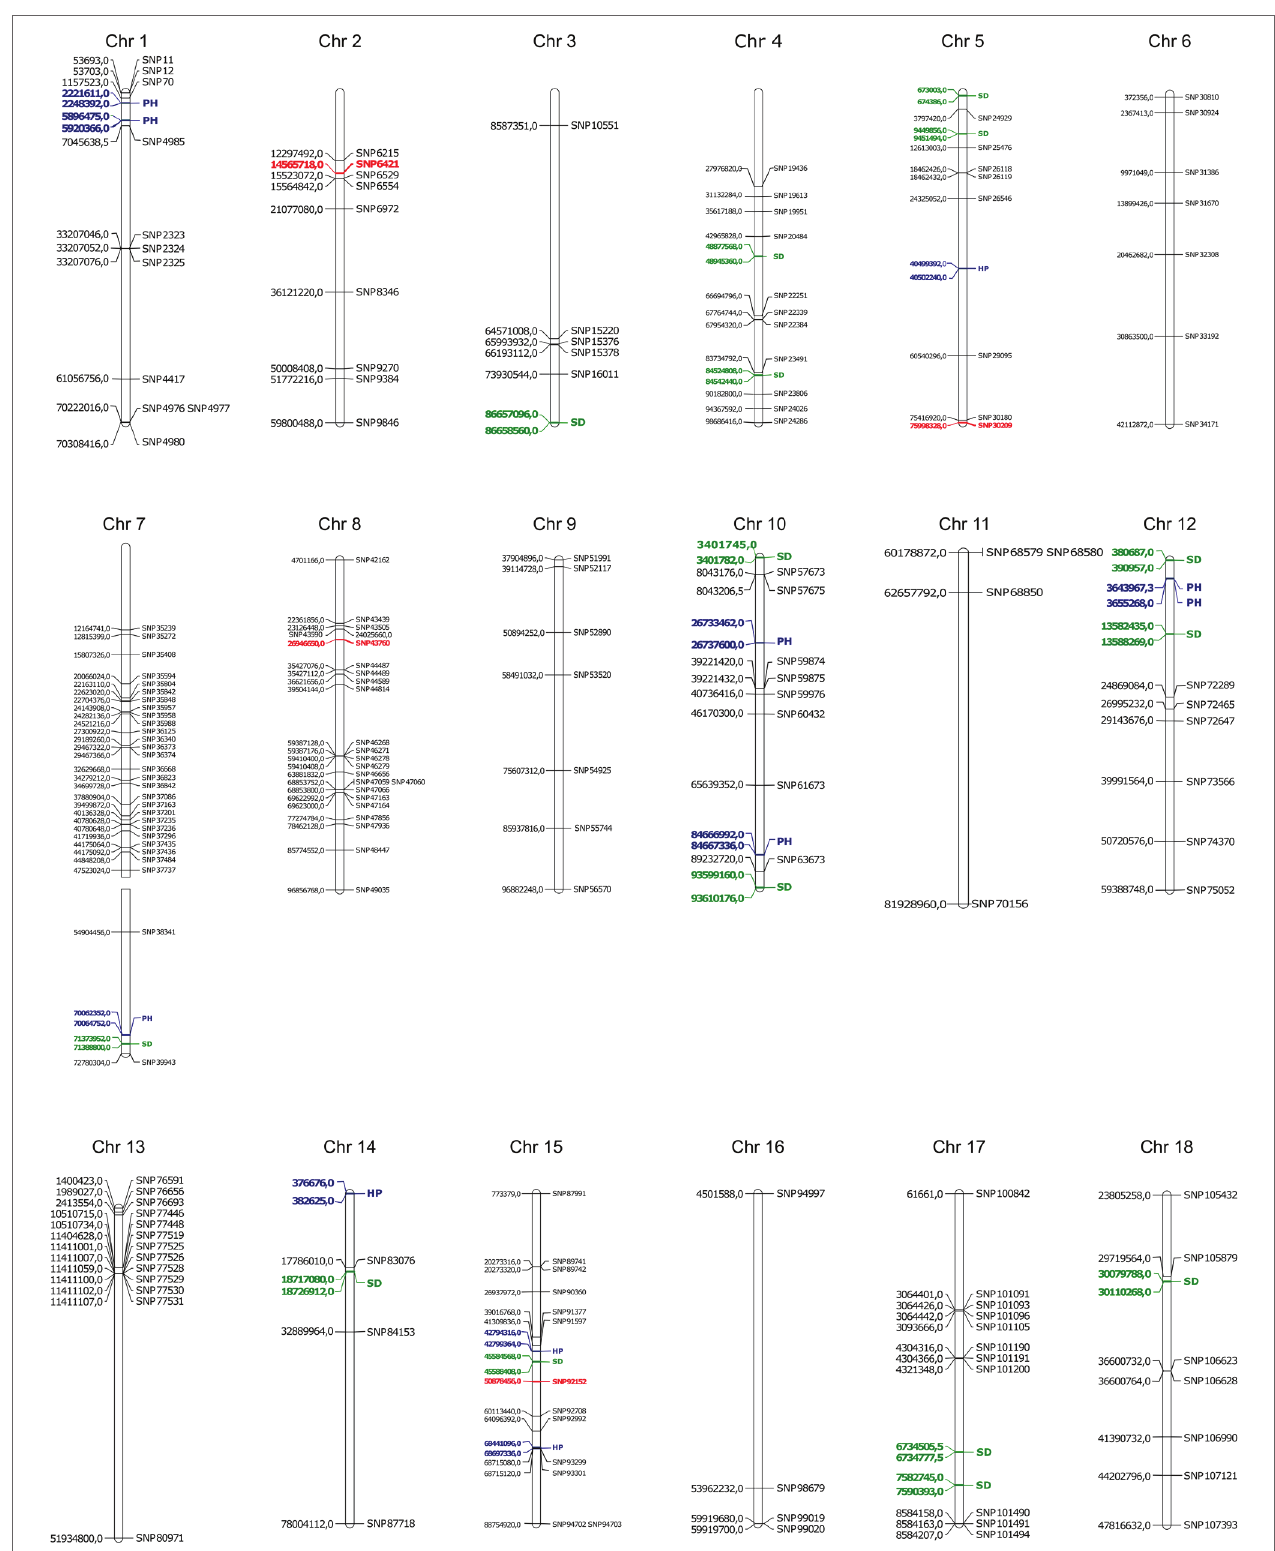
FIGURE 3 | Physical position of snpsGWAS in red, snpsLD in black and QTLs discovered by Conson et al. (2018). The QTLs for plant height (PH) are in blue and those for stem diameter (SD) are in